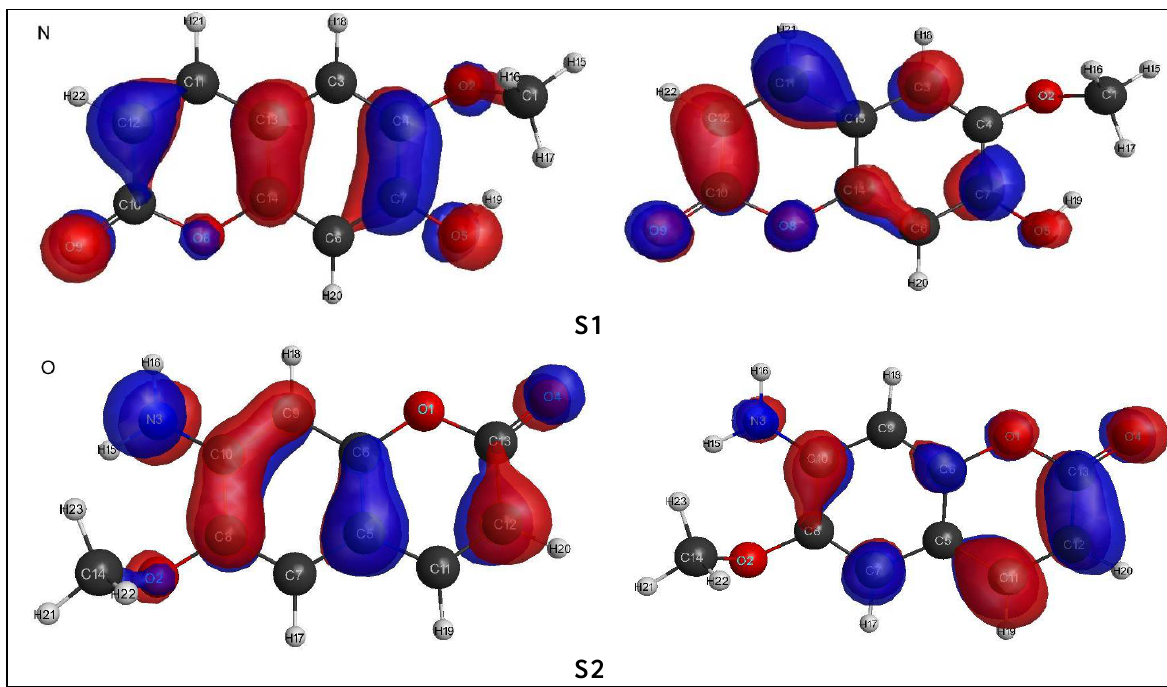
Figure S2 : The color-coded contour maps illustrating the variation of molecular electrostatic potentials over the regions of the ligands in the constructed